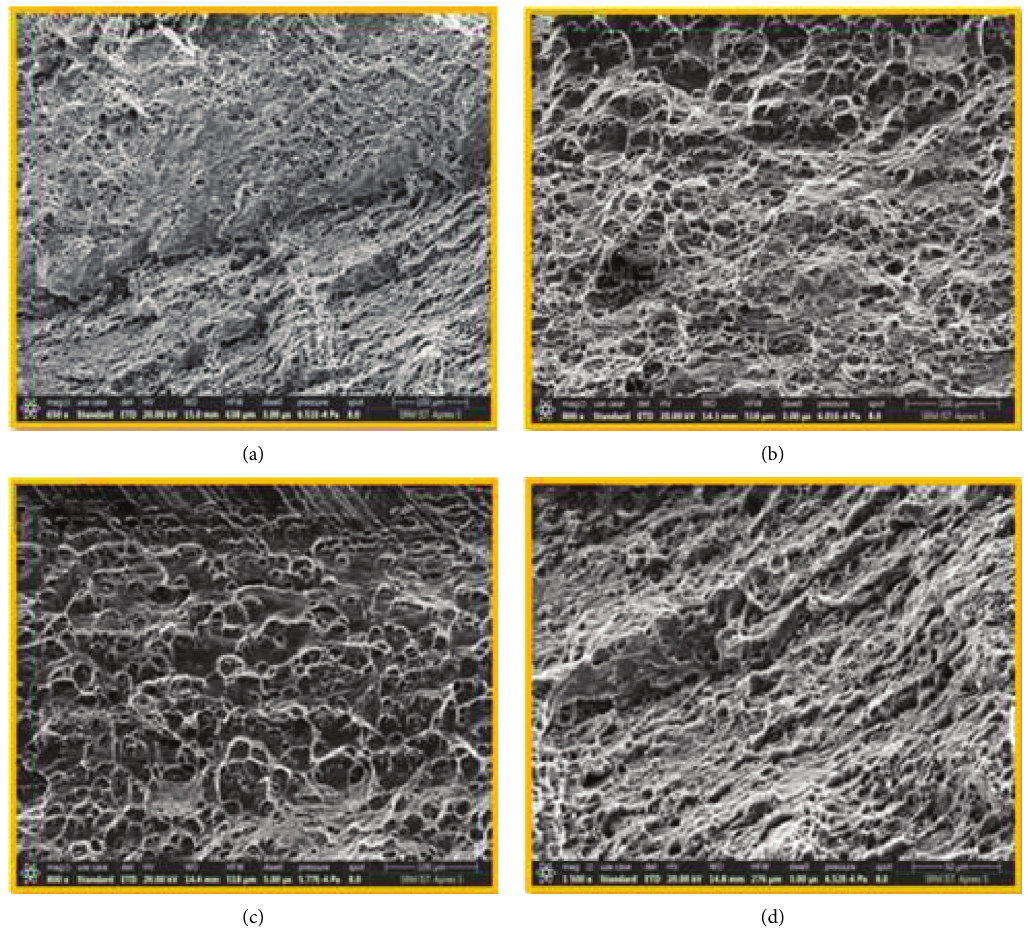
Figure 10: SEM images of tensile fractured weld